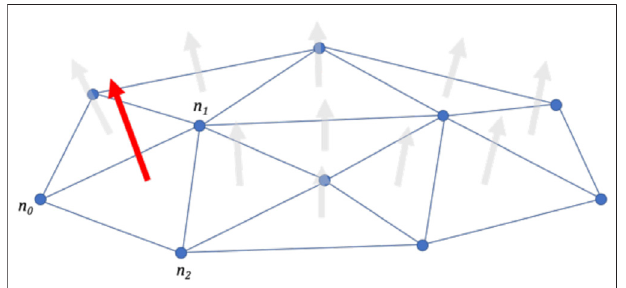
FIGURE 9 | Calculating the normal vector of a plane